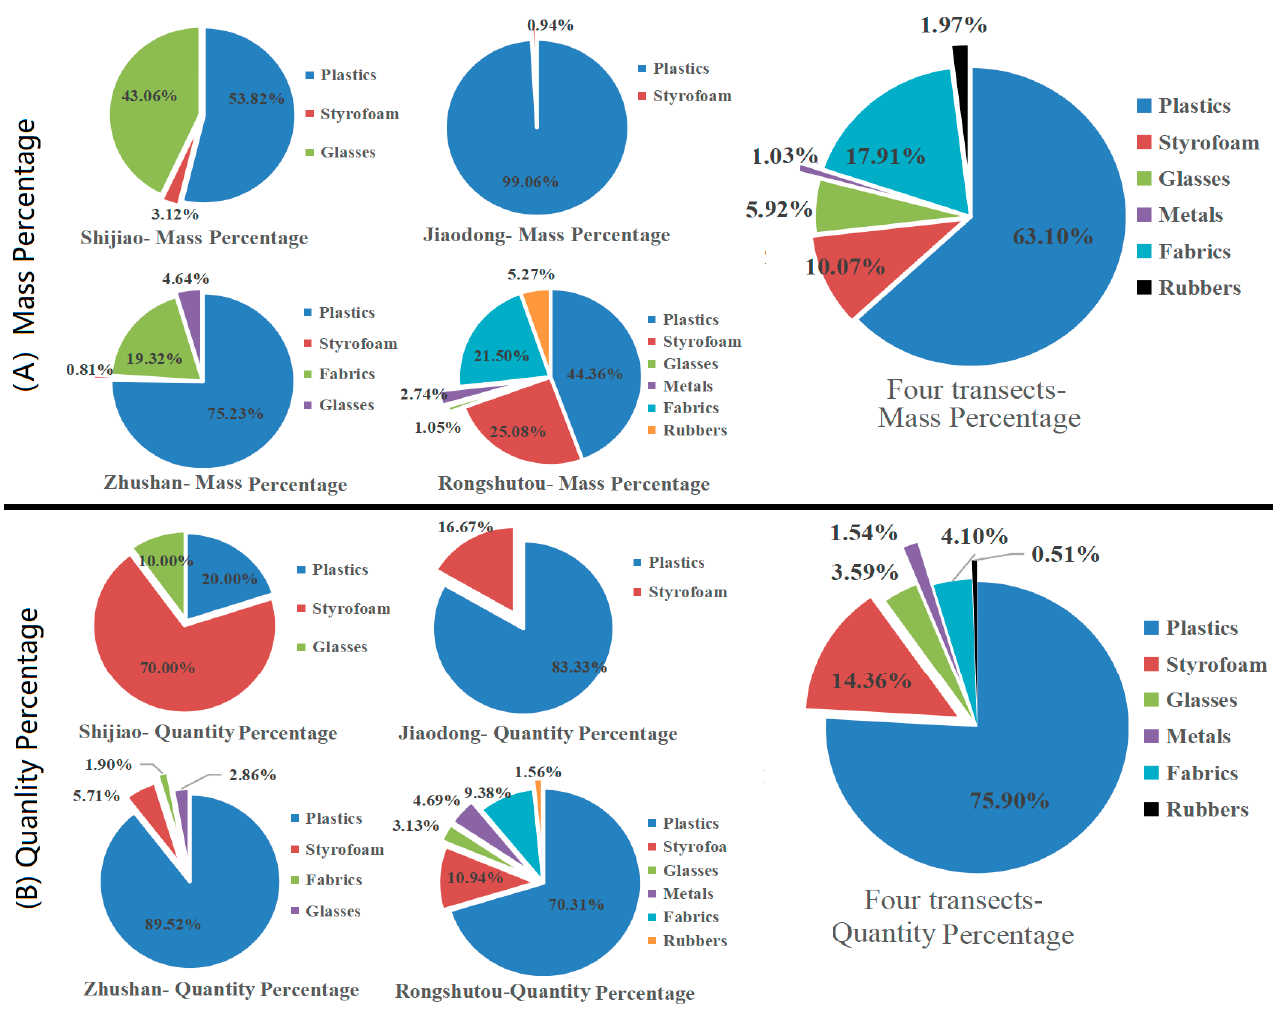
Figure 4. The mass ( A ) and quantity ( B ) percentages of the debris. Table 4. Source of marine debris in Beilun Estuary mangrove forest